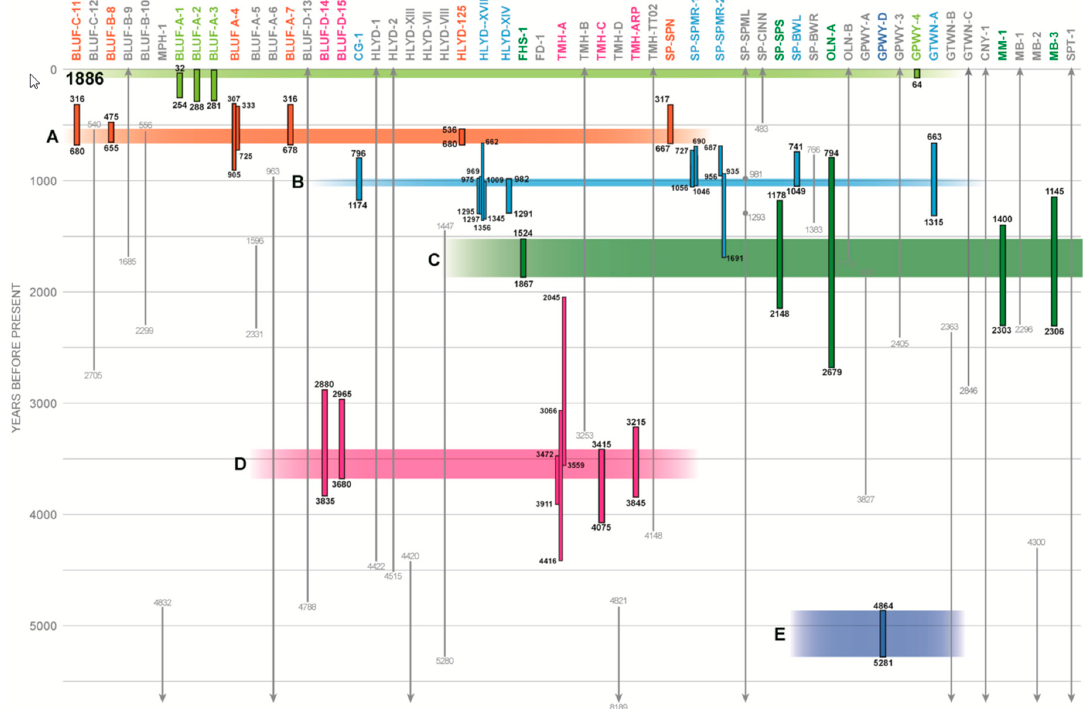
Figure 25. Earthquake chronology of the Charleston seismic zone for the past ~5500 years based on paleoliquefaction studies [35]. Text across top of figure indicates paleoliquefaction site name from Bluffton, South Carolina (BLUF) on the southwest to South Port, North Carolina (SPT) on the northeast (not to scale) [12]. Vertical bars represent radiocarbon age estimates of individual sand blows, and horizontal bars represent inferred event times based on intersection of overlapping age estimates: 64 years BP (AD 1886); 536–655 years BP (Event A); 982–1046 years BP (Event B); 1524–1867 years